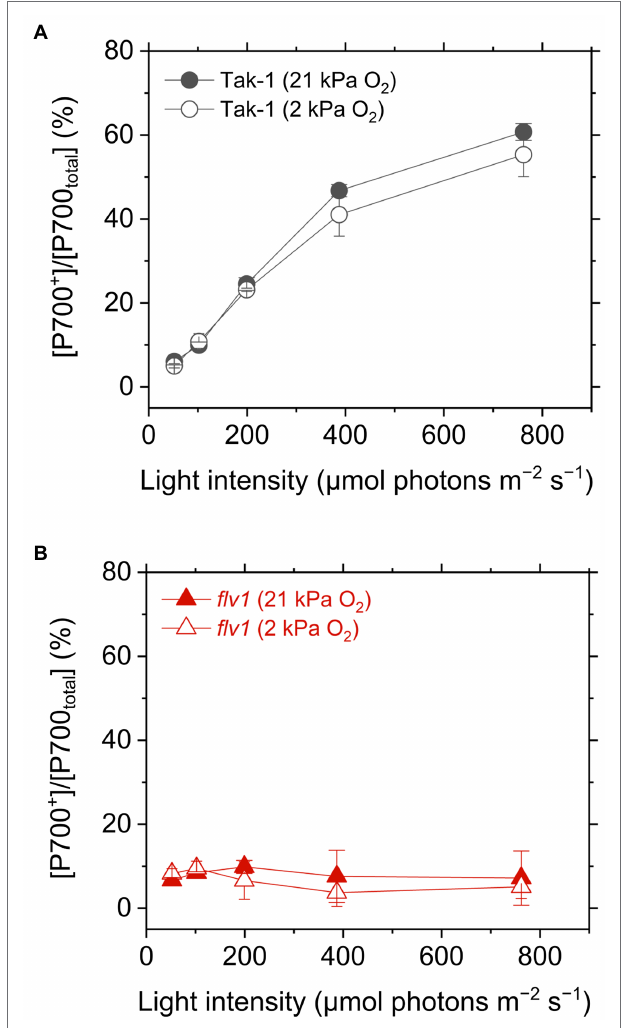
FIGURE 4 | Oxidation of P700 in the liverwort M. polymorpha (Tak-1; A ) and the mutant flv1 (B) . Experiments were performed under 21 (closed symbols) and 2 kPa O 2 (open symbols). Data are shown as the mean with the standard deviation ( n = 3, biological